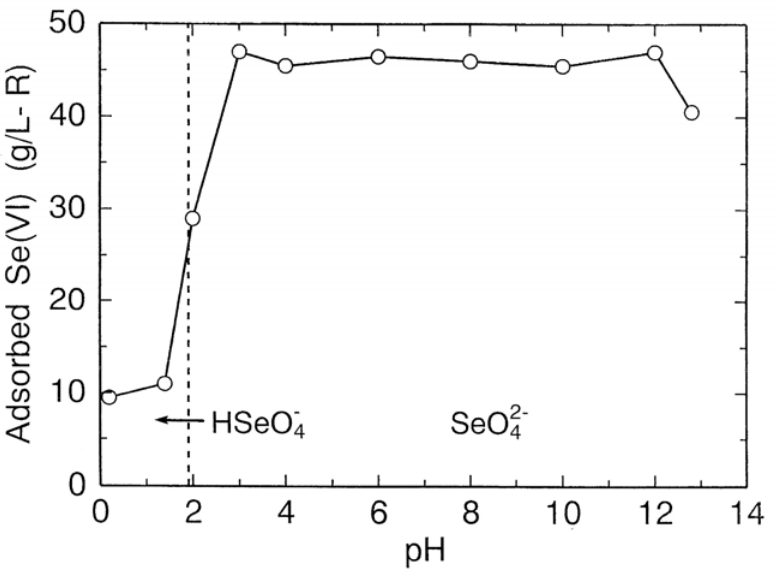
Figure 16. Effect of pH on adsorption of selenium(VI) on